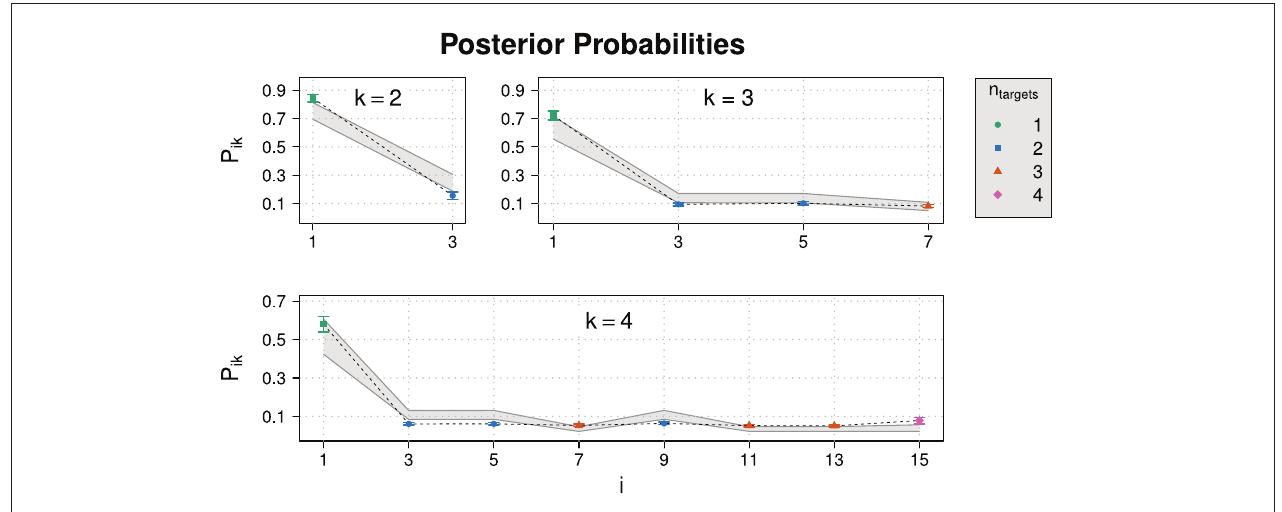
FIGURE 6 | Experimental results for the posterior probability for normalized slider values P ik for different states i and domain sizes k in Experiment 1. Also shown are posterior predictive 95% HDIs (gray areas).